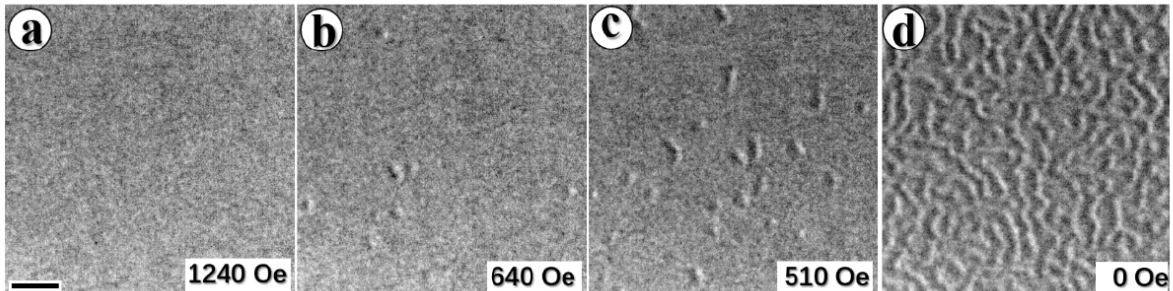
Figure A1. Lorentz TEM Fresnel images showing the corresponding domain evolution at decreasing the magnetic field ( a ) 1240, (saturation state) ( b ) 640, (skyrmions) ( c ) 510, (mixed states), and ( d ) 0 Oe, (stripe phase). The scale bar in ( a ) is 500 nm.